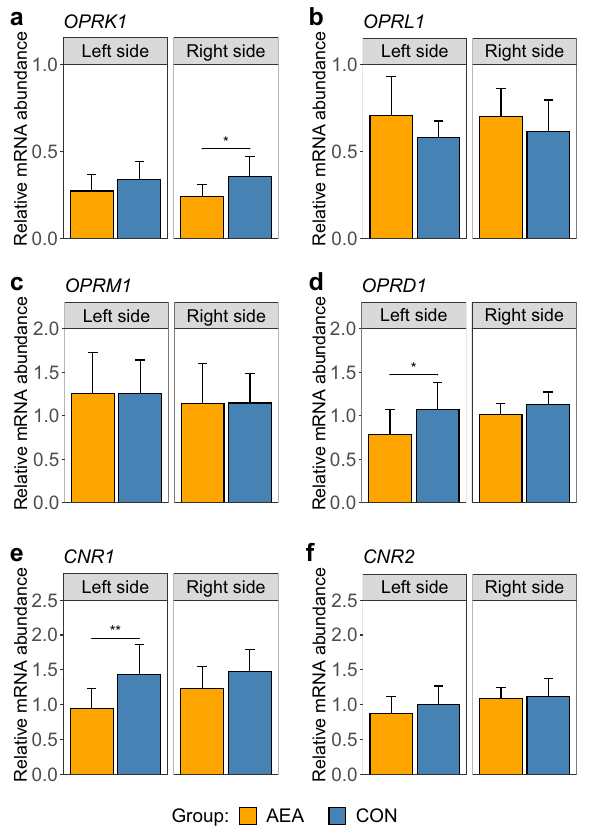
Figure 4. Relative mRNA abundance of ( a ) opioid receptor kappa 1 ( OPRK1 ), ( b ) opioid related nociceptin receptor 1 ( OPRL1 ), ( c ) opioid receptor mu 1 ( OPRM1 ), ( d ) opioid receptor delta 1 ( OPRD1 ), ( e ) cannabinoid receptor 1 ( CNR1 ) and ( f ) cannabinoid receptor 2 ( CNR2 ) in left and right amygdala of cows treated intraperitoneally with NaCl (CON, left hemisphere n = 8, right hemisphere n = 8) or N -arachidonoylethanolamide (AEA, left hemisphere n = 8, right hemisphere n = 8). The mean of the observed data ± SD is shown for interpretation. * P < 0.05, ** P <